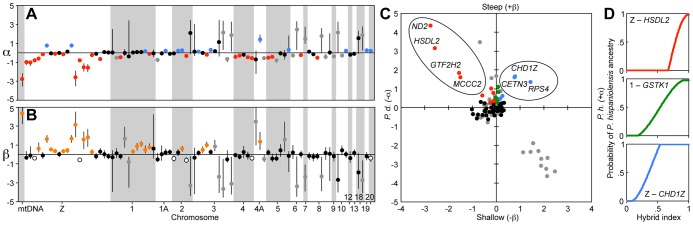
Candidate RI genes revealed by genomic cline analysis.(A–B) Markers are ordered along chromosomes as in Table S3. (A) BGC run 2 estimates of genomic cline center (α) with 95% credibility intervals for all 86 SNP markers. Red dots indicate markers with significant excess house sparrow ancestry, blue dots indicate markers with significant excess Spanish sparrow ancestry, grey dots indicate markers with either significant house or Spanish excess ancestry but where the difference in allele frequency between the parent species are below 0.5, and black dots indicate markers that do not differ from neutral expectations. (B) BGC run 2 estimates of genomic cline rate (β) with 95% credibility intervals for all 86 SNP markers. Orange dots indicate markers with clines significantly steeper than neutral expectations, white dots indicate markers with significantly shallower clines than neutral expectations, grey dots indicate markers with either significantly steeper or shallower clines than neutral expectations but where the difference in allele frequency between the parent species is below 0.5, and black dots indicate markers that do not differ from neutral expectations. (C) Genomic cline center (α) plotted against genomic cline rate (β). Red dots indicate markers that exhibit significant excess house sparrow (P. d.) ancestry, clines steeper than neutral expectations and where the difference in allele frequency between the parent species is greater than 0.5. The red dots that are encircled and named shift at the Italian-Spanish boundary and are hence candidate RI genes. Blue dots indicate markers that exhibit significant excess Spanish sparrow (P. h.) ancestry, clines steeper than neutral expectations and where the difference in allele frequency between the parent species is greater than 0.5. The blue dots that are encircled and named shift at the Italian-house boundary and are hence candidate RI genes. Green dots indicate markers that have allele frequency differences between the parent species greater than 0.5 and clines steeper than neutral expectations but do not exhibit excess house or Spanish sparrow ancestry. These markers are candidates for being incompatibilities within the Italian sparrow. Grey dots indicate markers in which the allele frequency difference between the parent species is less than 0.5. (D). Examples of BGC genomic clines representative of the marker categories described in panel (C). For illustrations of all clines, see Figure S2.